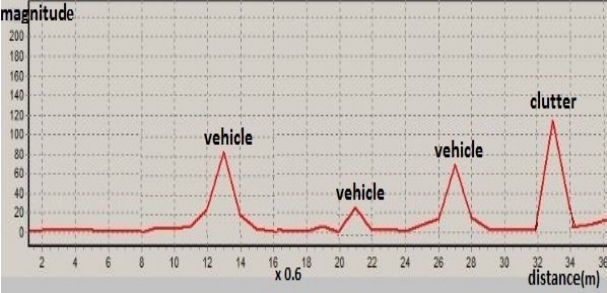
Figure 15. A snapshot of edged FFTs of received vehicle signals and clutter.